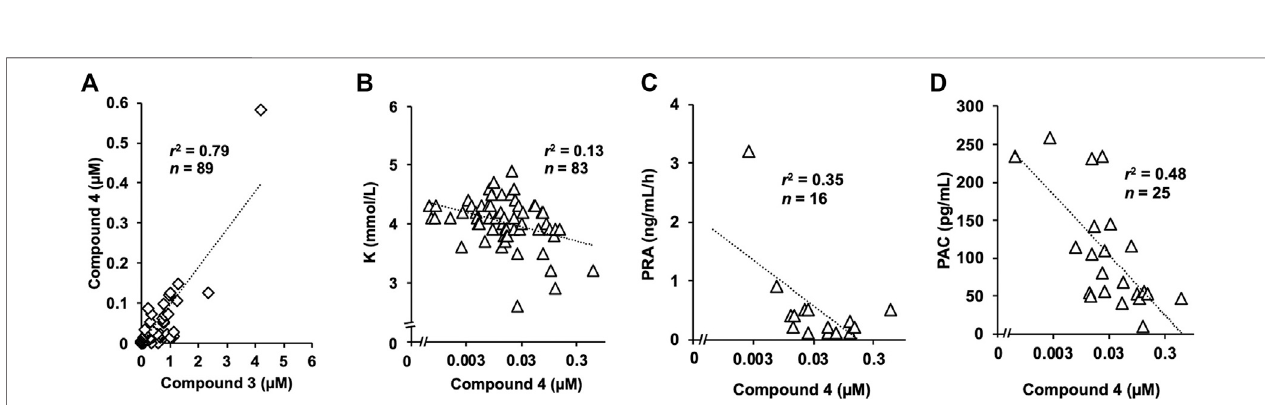
FIGURE 3 | Concentration of 4 in human serum samples and three or laboratory markers (A) Strong positive correlation was identi fi ed between serum concentrations of 3 and 4 . The concentration of 4 was approximately 10-fold lower than that of 3 (B) Serum potassium concentration tended to be lower in participants with higher serum concentration of compound 4 (C) Plasma renin activity and (D) plasma aldosterone concentration were also suppressed in patients with higher concentration of compound 4 , which were negatively correlated.